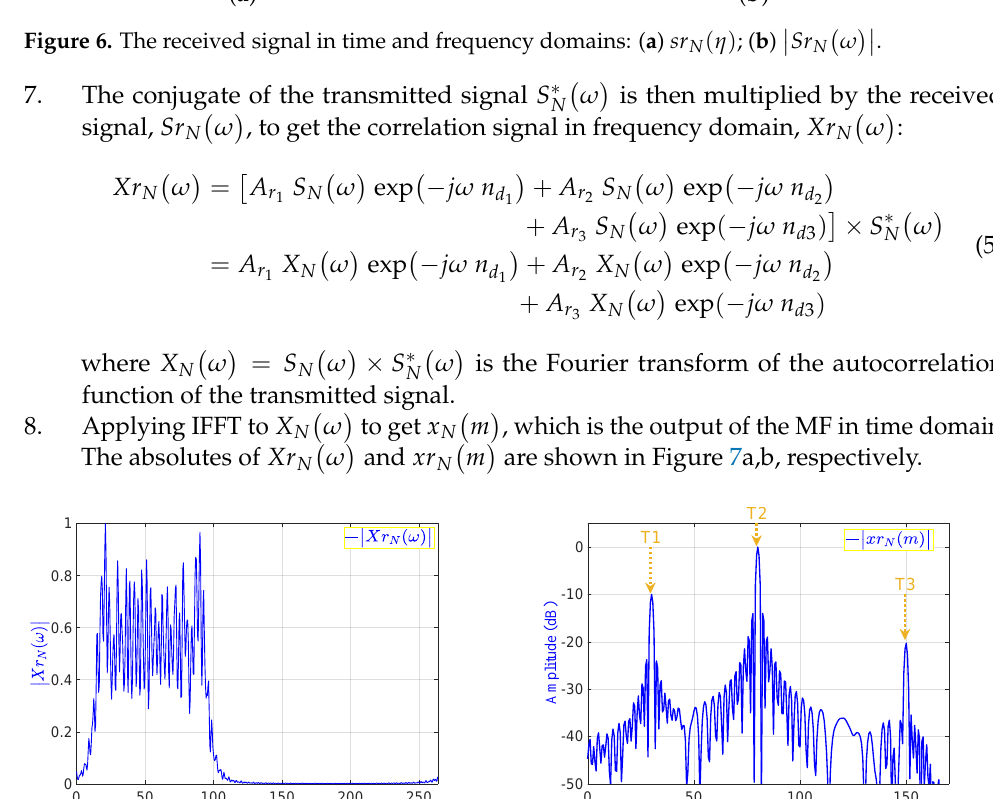
(cid:12) (cid:1)(cid:12) (cid:12) (cid:1)(cid:12) (cid:0) (cid:0) m ω (cid:12) Xr N (cid:12) ; ( b ) (cid:12) xr N (cid:12) . (cid:0) (cid:1) ω , is given by: